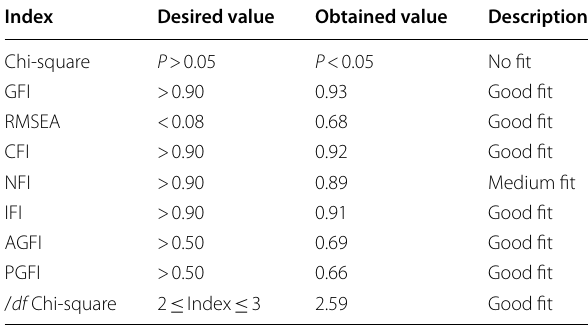
The highest coefficient has been highlighted in italic which shows the strongest impact Table 9 Fit indices of model